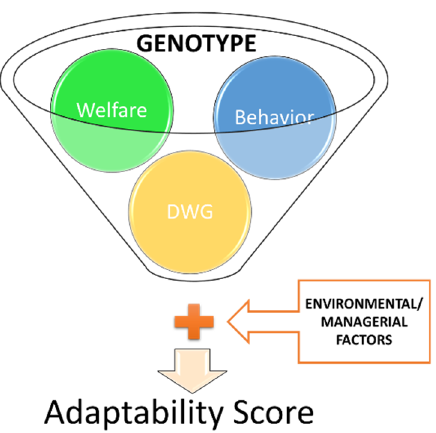
Figure 3. Graphical representation of the influence of the main parameters investigated on the AS and their interaction.